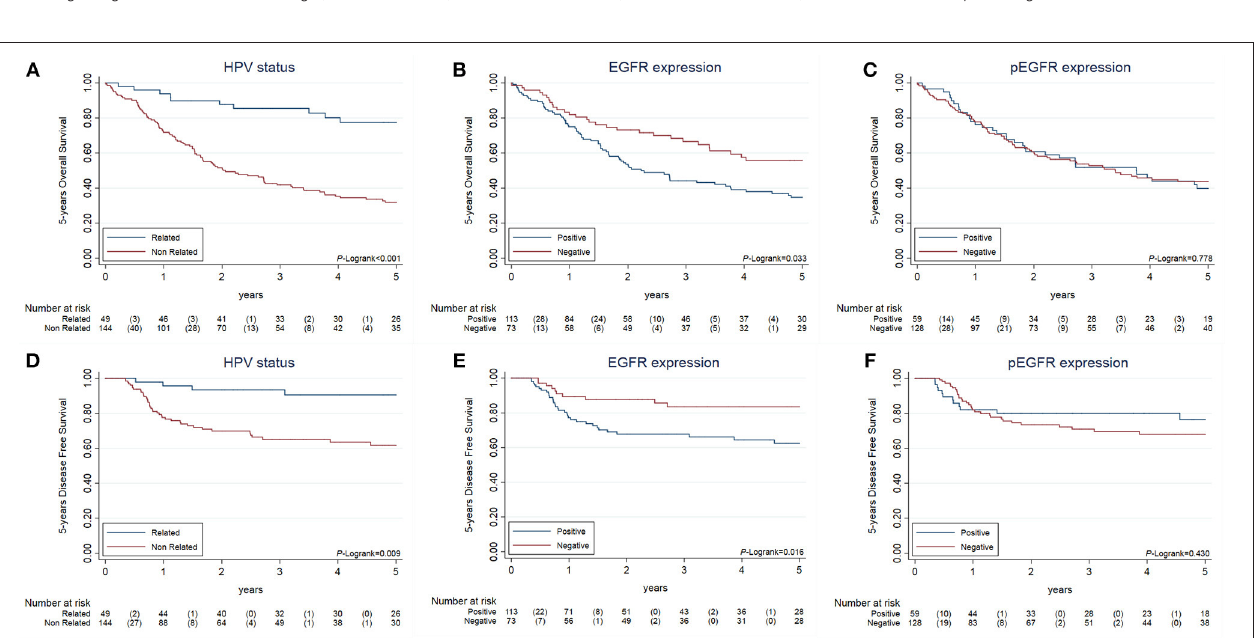
Frontiers in Oncology |